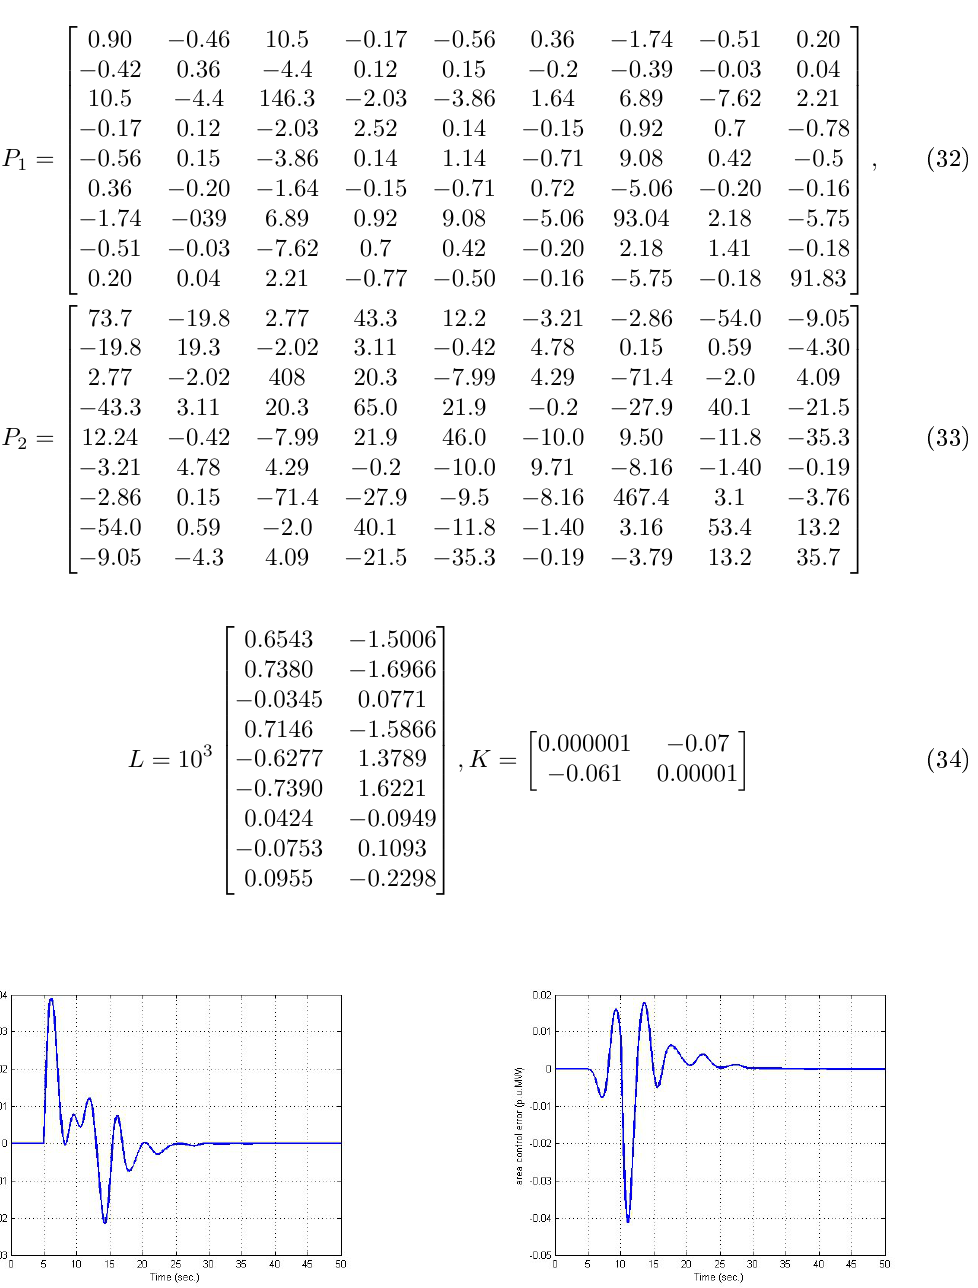
Fig. 11: ACE in control area 2 (Case 2)